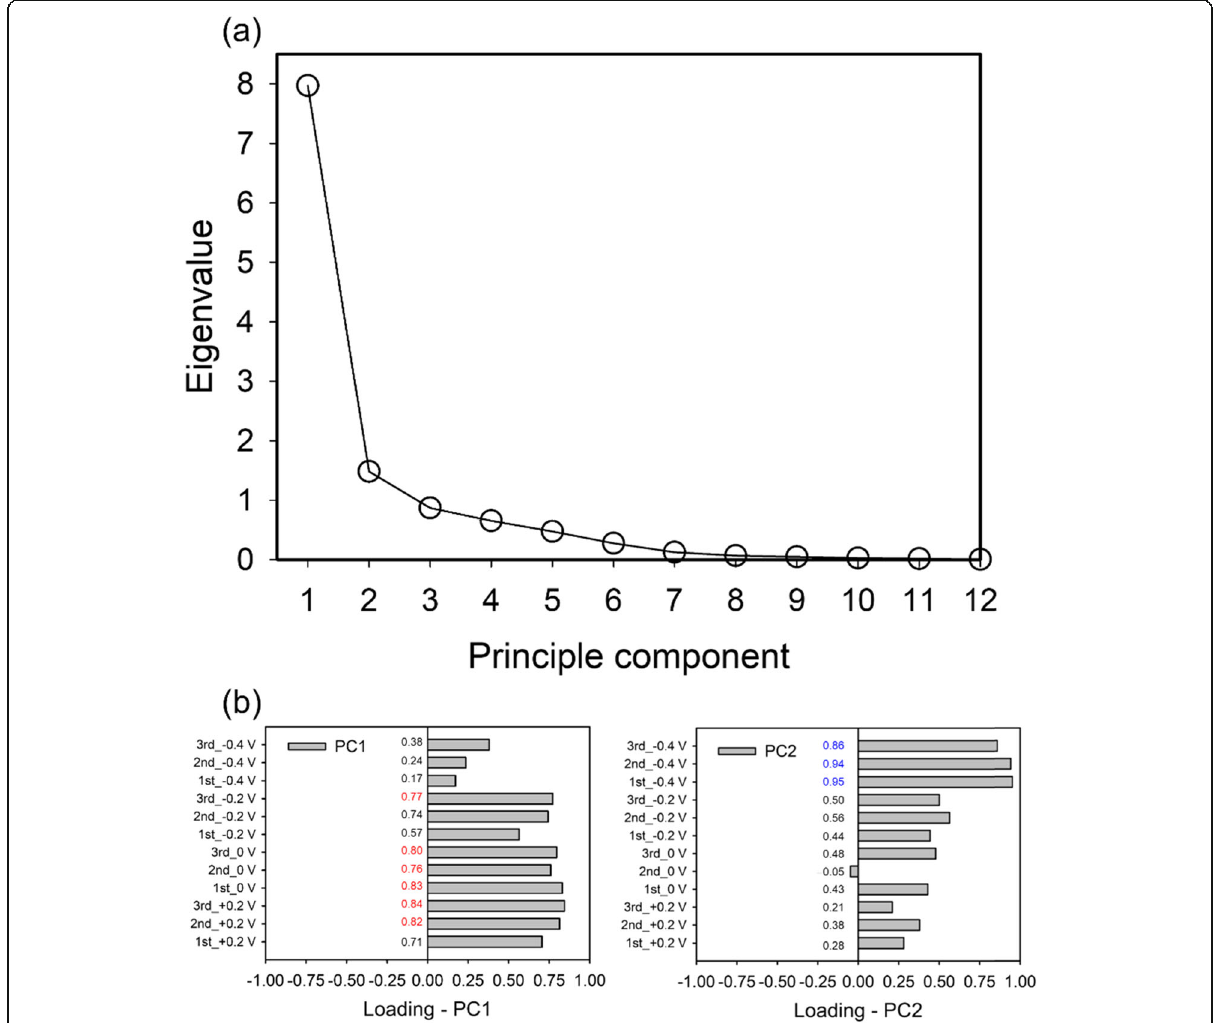
Fig. 5 Scree plots and Rotated component matrix of PC1 and PC2 in PCA analysis. ( a ) Scree plot. ( b ) Rotated component matrix of PC1 and PC2 and marked variables (red in PC1, blue in PC2) when loadings were higher than